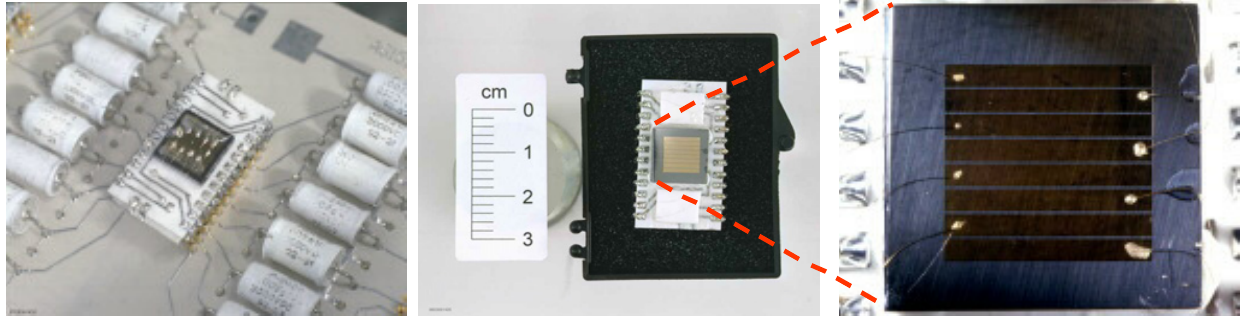
Figure 3. The 1 cm 2 CZT array sits on a dip package on a circuit board for a handheld gamma radiation